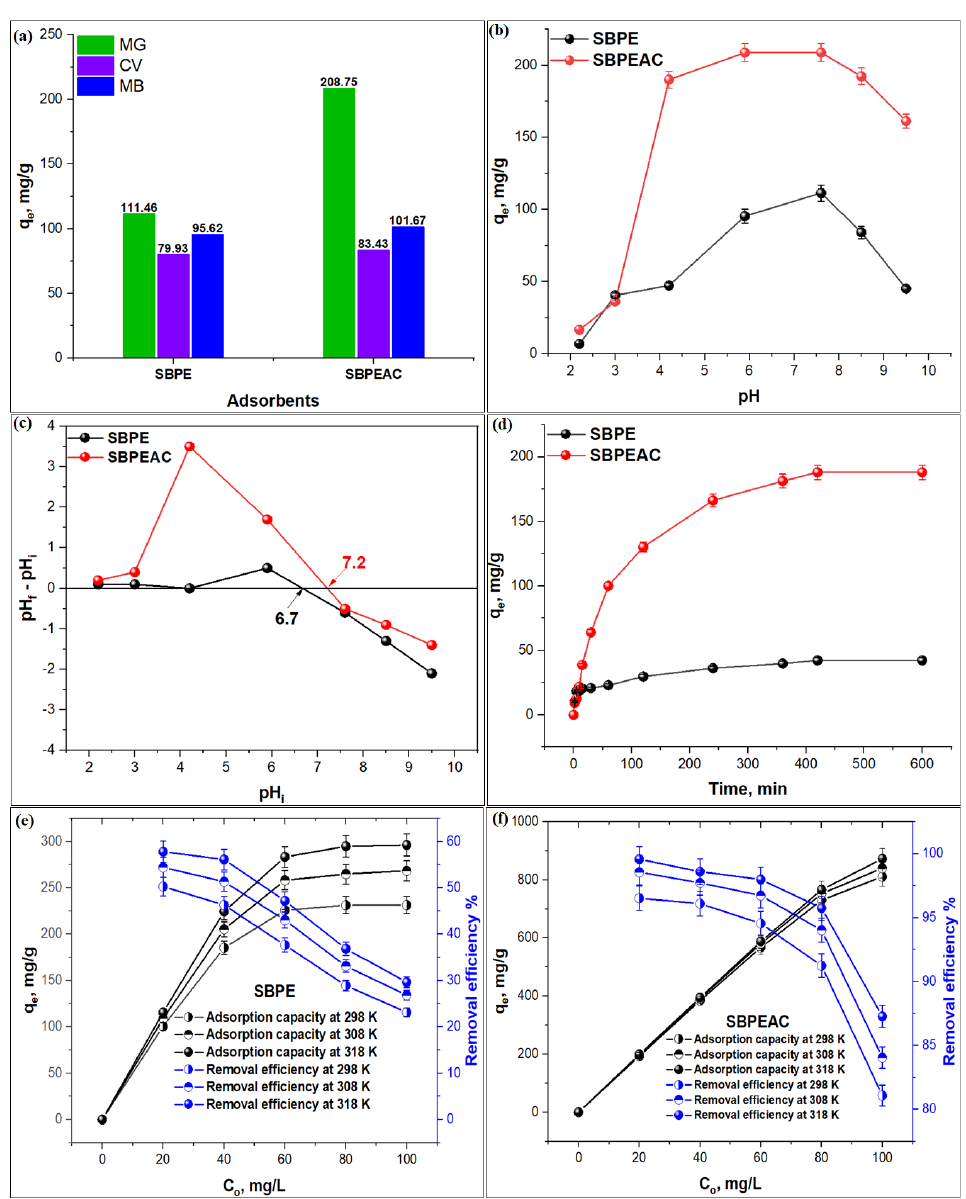
Figure 4. Selectivity study plot of SBPE and SBPEAC composites ( a ), Effect of pH ( b ), Zeta potential ( c ), Contact time ( d ), Initial MG concentration on MG adsorption onto SBPE ( e ), and SBPEAC composites ( f